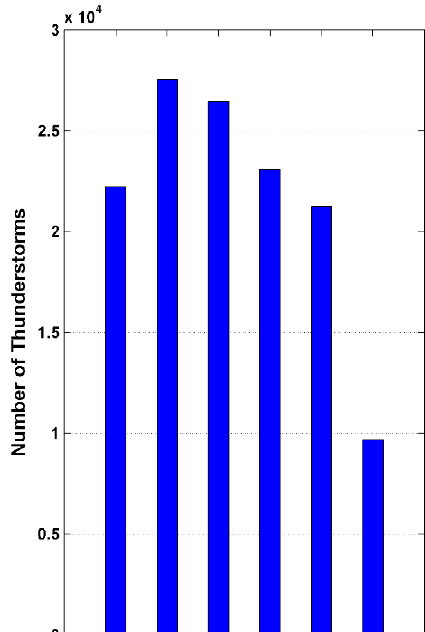
Figure 7. Histogram of thunderstorm initiation (blue) and termination (red) time during a day. Figure 8 shows the monthly rose diagrams of thunderstorm movement speed and direction. The monthly average movement speeds are 63.2 km/h (April), 53.8 km/h (May), 48.1 km/h (June), 38.1 km/h (July), 42.5 km/h (August), and 47 km/h (September), which are similar to the climatological analysis in North Dakota in Mohee and Miller [33]. For movement direction, thunderstorms are most common between 0 and 90 degrees, with an average thunderstorm vector from the southwest to northeast during the warm seasons from 2010 to 2014.